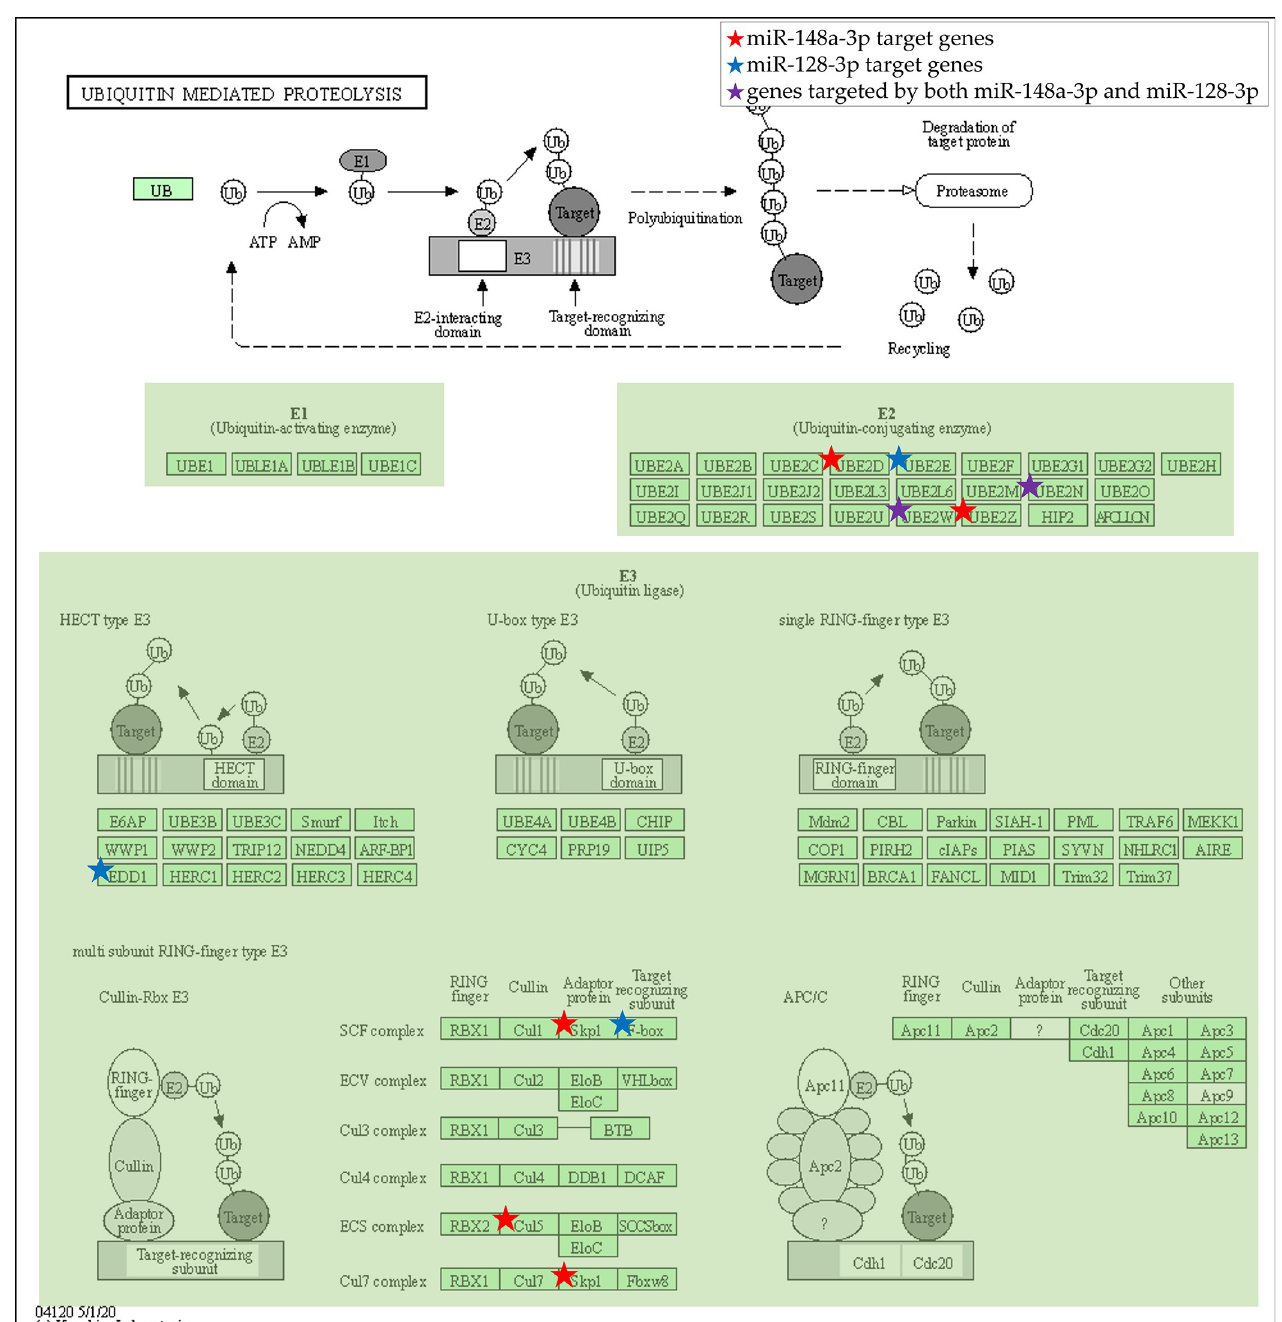
Fig 4. KEGG pathway map of ubiquitin-mediated proteolysis with the genes putatively targeted by miR-148a-3p and miR-128-3p. Genes marked with stars indicate the target genes of miR-148a-3p and miR-128-3p altered by acute subanesthetic ketamine treatment. Genes predicted to be targeted by miR-148a- 3p are marked in red, and genes predicted to be targeted by miR-128-3p are marked in blue. Genes predicted to be targeted by both miRNAs are marked in purple. prostate cancer cells [41], which indicates that the genes involved in ubiquitin-mediated prote- olysis can be targeted by miR-148a-3p. Importantly, our data predicted that miR-148a-3p tar- gets Skp1 and Cul5, which are multi subunit RING-finger type E3 that can regulate synaptic